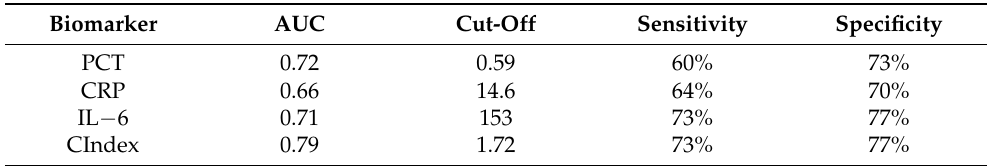
Table 2. Values for ROC curve performance measurements for a chosen cut-off value, maximising both sensitivity and